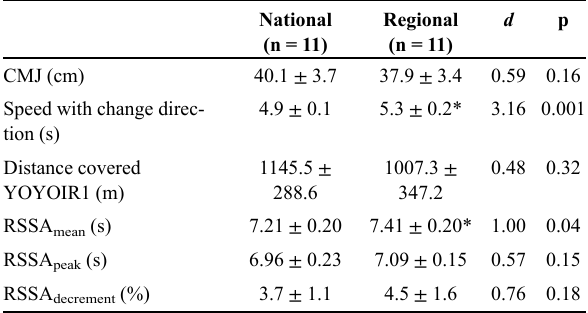
Table 1 - Physical performance description and comparison between national and regional level futsal athletes (n = 22).